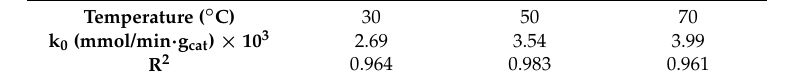
Table 6. Initial reaction rate values for CWPO of NAP at different temperatures.